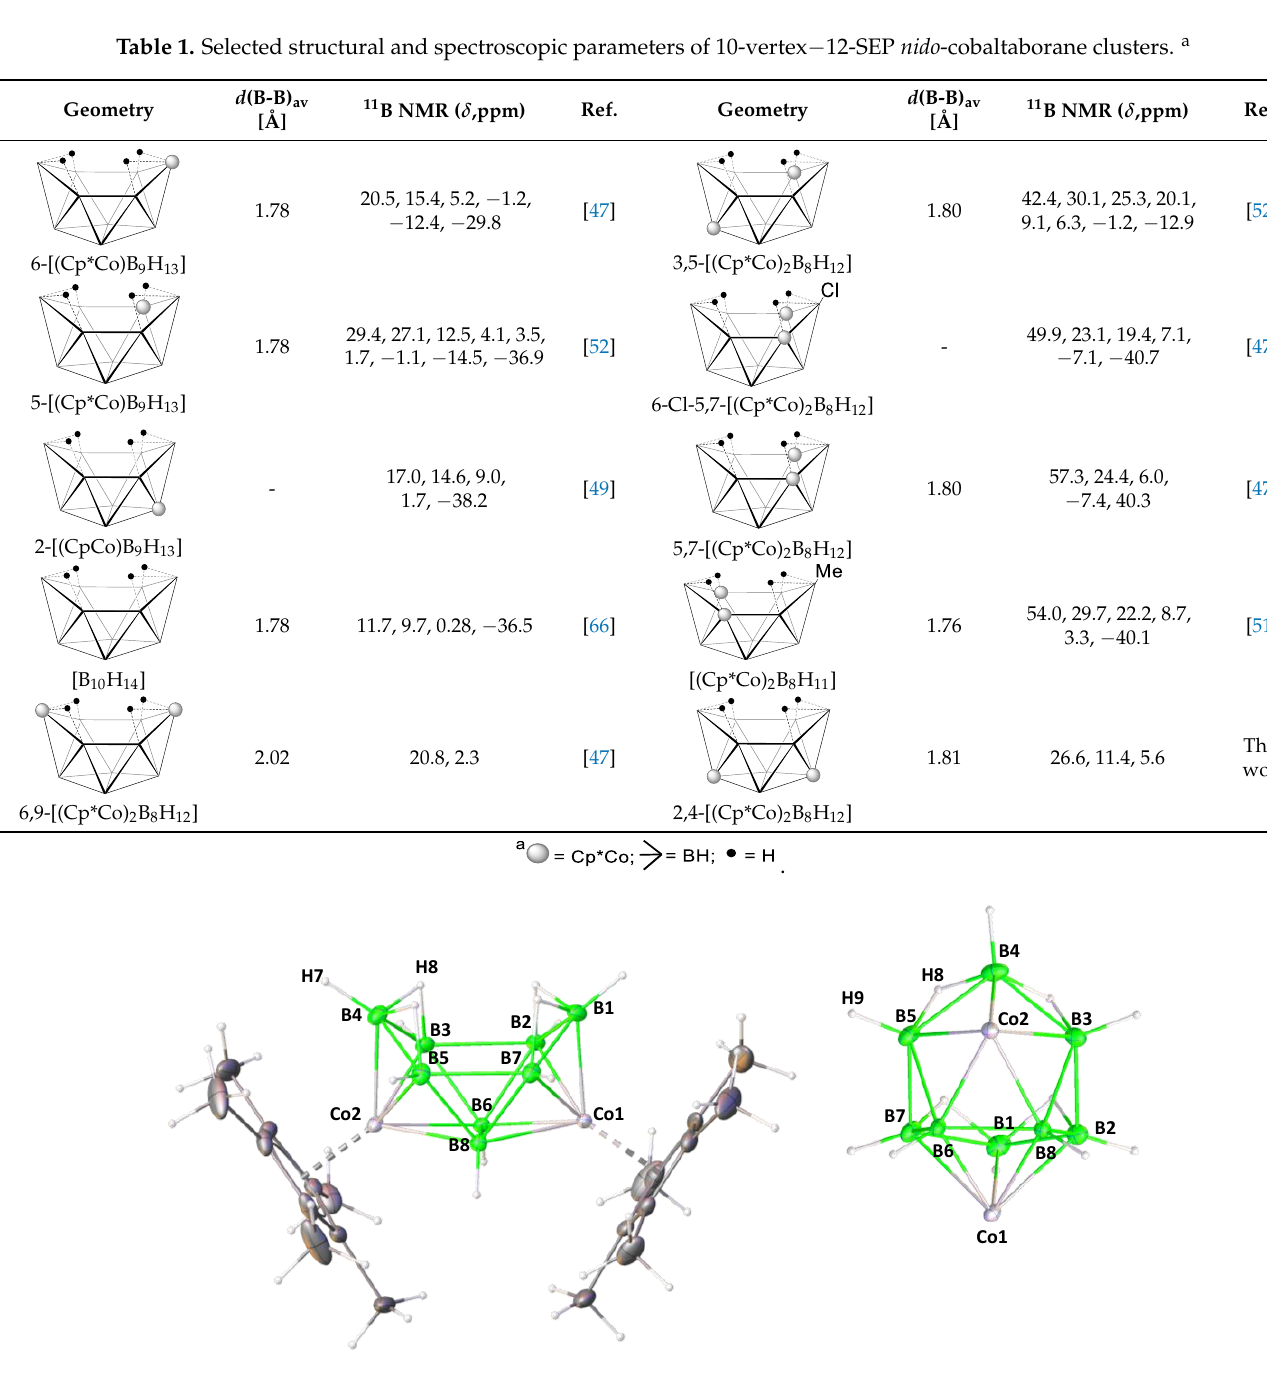
Figure 5. Molecular structure and atom labels for 2 : frontal view (left) and bottom angular view (right, Cp* ligands at- tached to Co are omitted for clarity). Selected bond lengths (Å ) and bond angles (°): B1–Co1 1.972(5), B2–B3 1.971(7), B2– Co1 2.043(5), B3–B4 1.807(8), B3–Co2 2.043(4), B5–Co2 2.041(5), B7–Co1 2.046(4), B3–B2–Co1 115.5(2), B4–B3–B2 116.3(4),